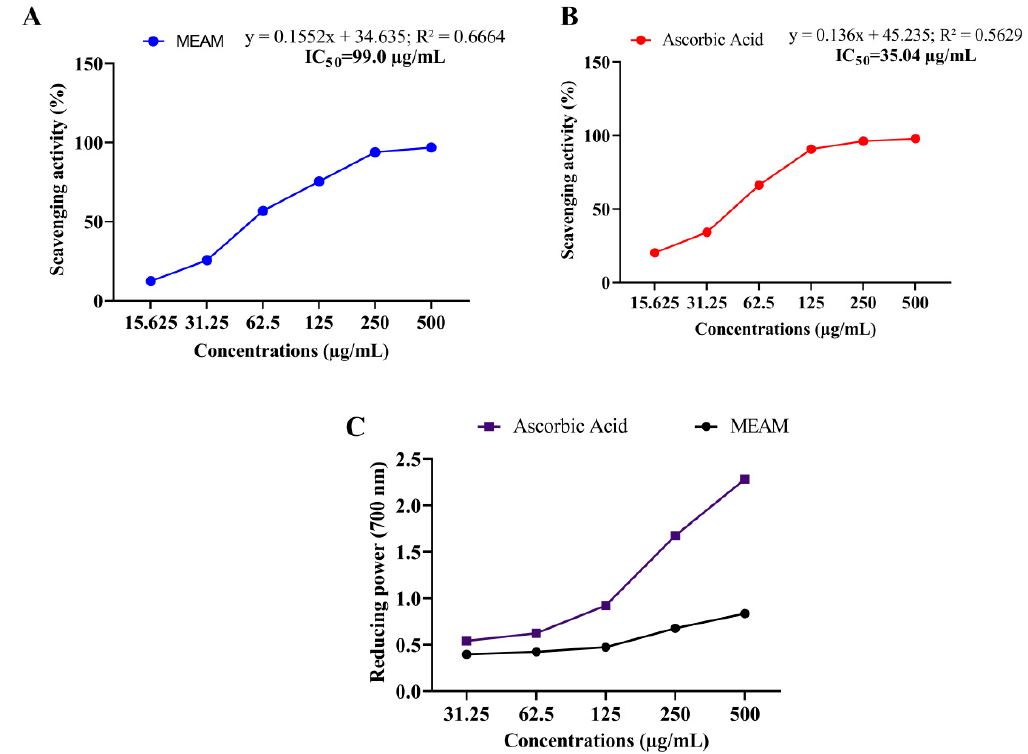
Figure 1. Antioxidant activity of methanol extract of A. montanum (MEAM): ( A ) DPPH free radical scavenging activity of MEAM; ( B ) DPPH free radical scavenging activity of ascorbic acid; and ( C ) reducing power capacity of MEAM and ascorbic acid. Values are presented as mean ± S.E.M. (n = 3).